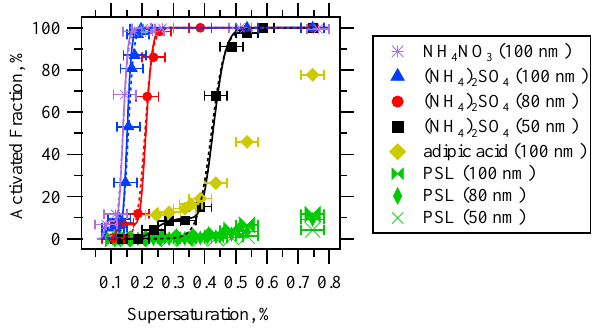
Fig. 2. Fraction of aerosols active as CCN as a function of super- saturation. The size and composition of the aerosol is differentiated by the shapes given in the legend. Dashed lines represent sigmoid fits to the single charged portions of the activation curves following Rose et al. (2008). Solid lines represent activation model of single and doubly charged components. The x-axis error bar represents 1S of ± 0.04%.